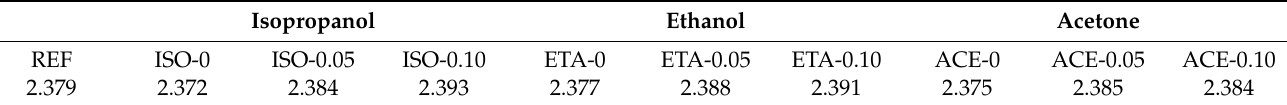
Table 6. Density results as determined by helium